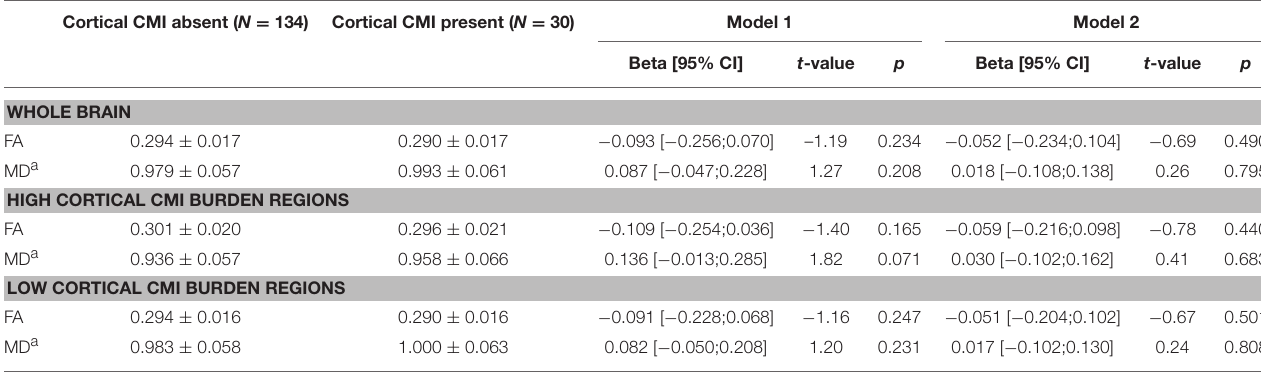
TABLE 2 | Association between cortical CMI presence and whole brain and regional FA- and MD-weighted WM connectivity in high and low CMI burden regions. Cortical CMI absent ( N = 134) Cortical CMI present ( N =